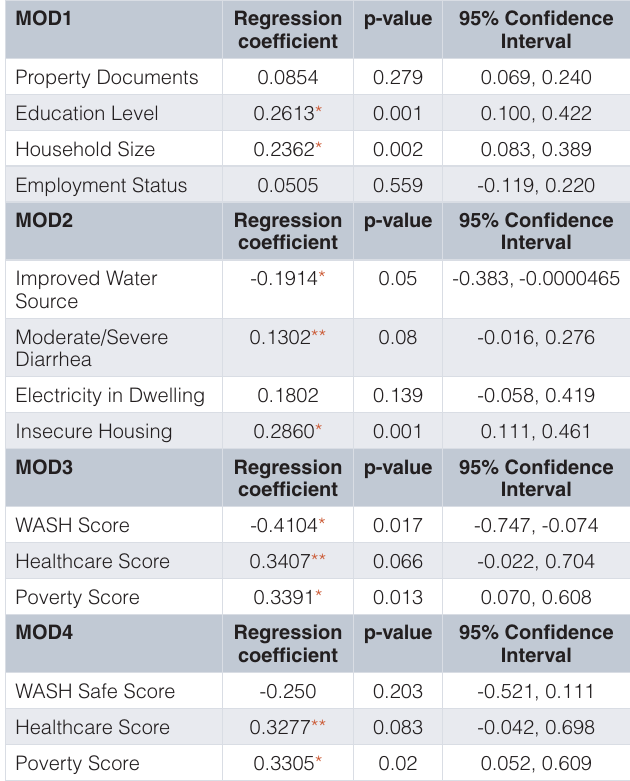
Time to Primary Drinking Water Source (Mean, 0–4 scale, 15min